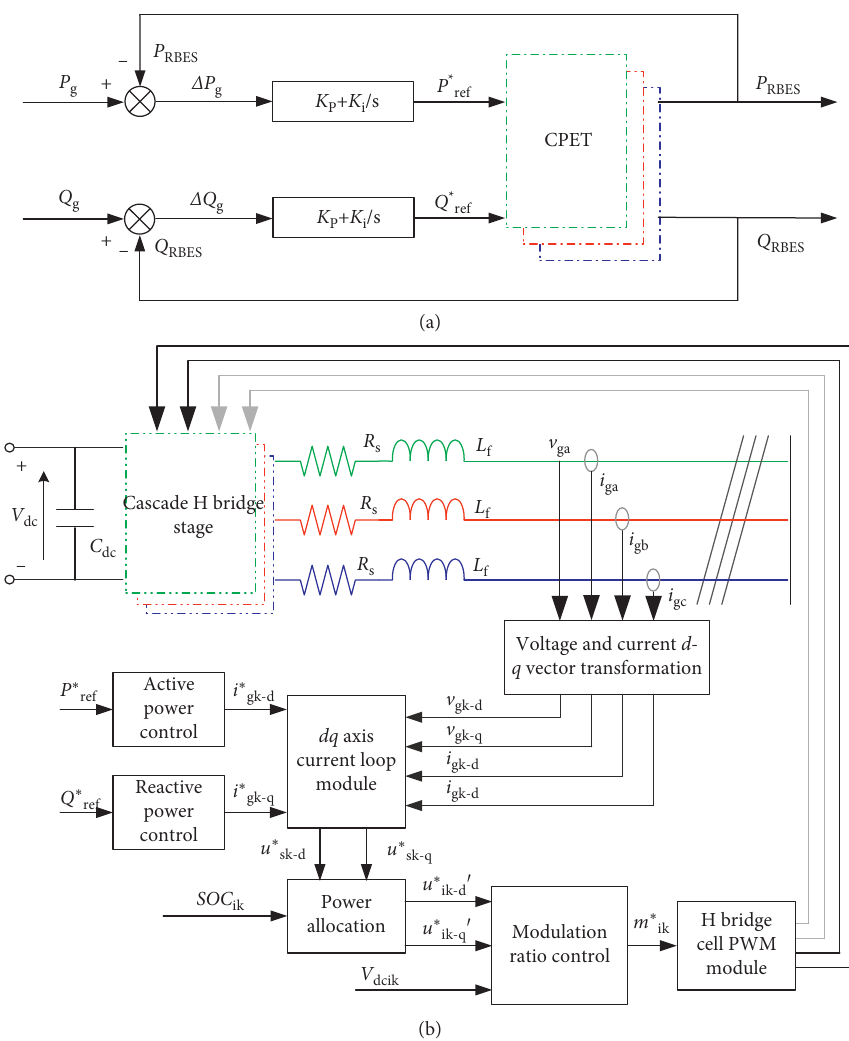
Figure 5: Power layer control strategy block diagram.